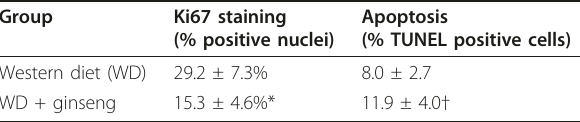
Table 1 Ginseng inhibits proliferation and increases cell death in colonic